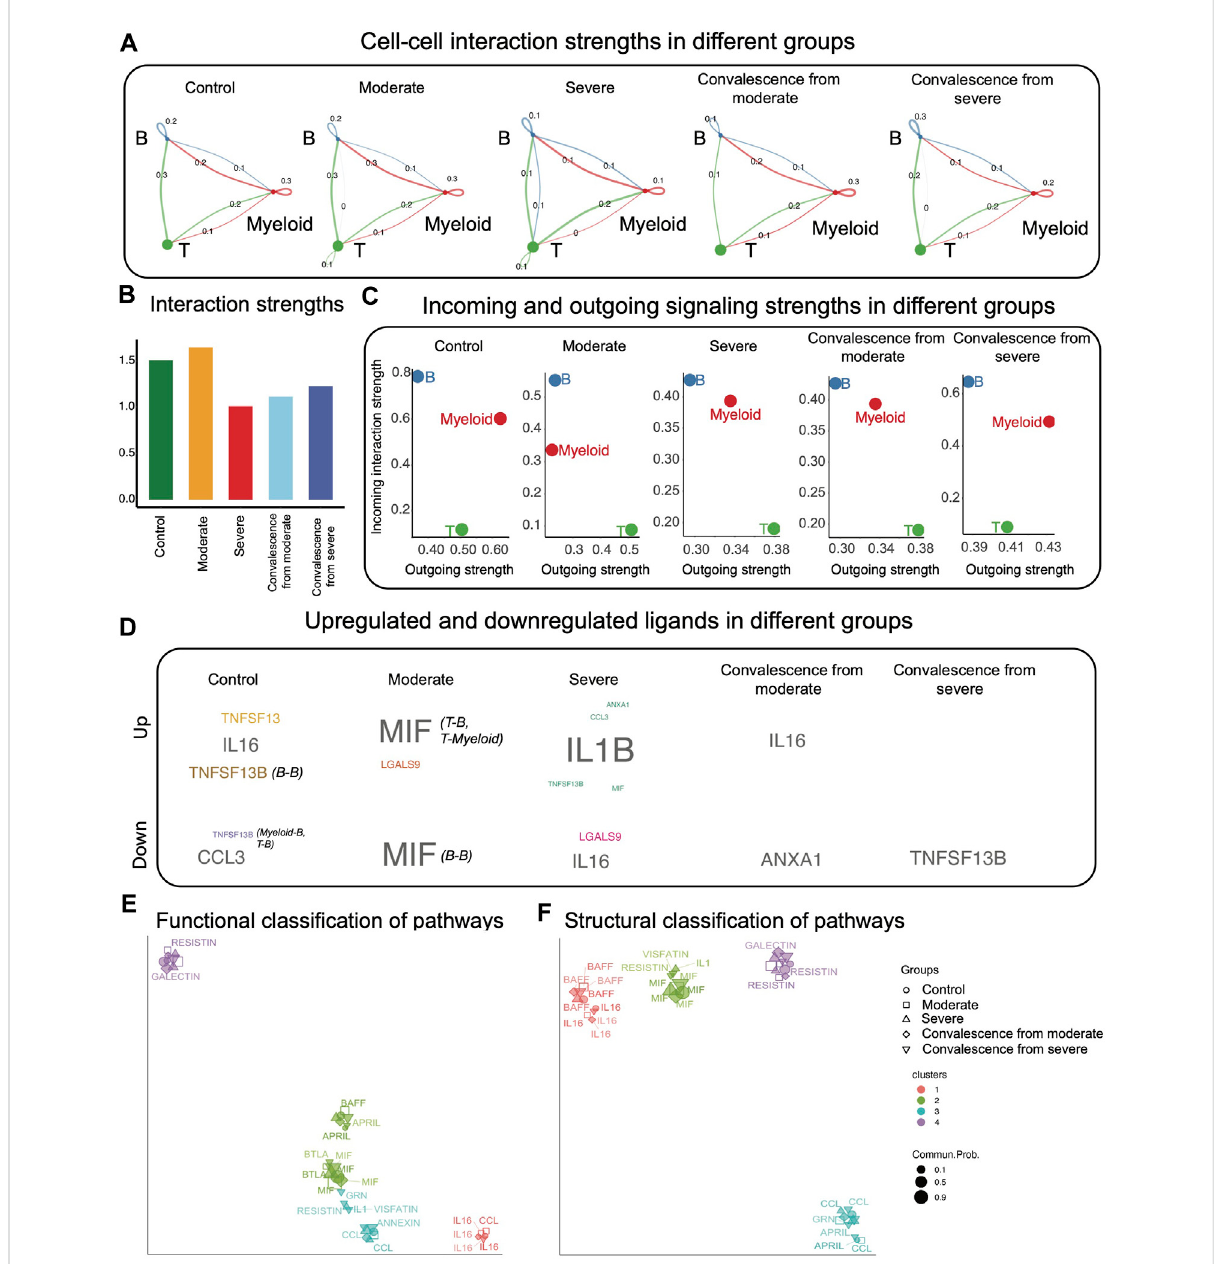
FIGURE 1 CCIanalysisusingCellChat. (A) CCIstrengths.Eachedgerepresentsaninteraction;thecoloroftheedgematcheswiththesendingcelltype. (B) Total interaction strength in different groups. Control and moderate groups have higher total interaction strength. (C) Total incoming and outgoing signaling strengths in different groups. B cells interact stronger as receivers than as senders, while T cells interact stronger as senders than as receivers. (D) Upregulated and downregulated ligands in different groups. (E) Using UMAP to project signaling pathways on a two-dimensional manifold according to their functional similarity. Each dot represents the interaction network of one signaling pathway. Different colors represent different groups of signaling pathways. (F) Using UMAP to project signaling pathways on a two-dimensional manifold according to their structural similarity. Each dot represents the interaction network of one signaling pathway. Different colors represent different groups of signaling